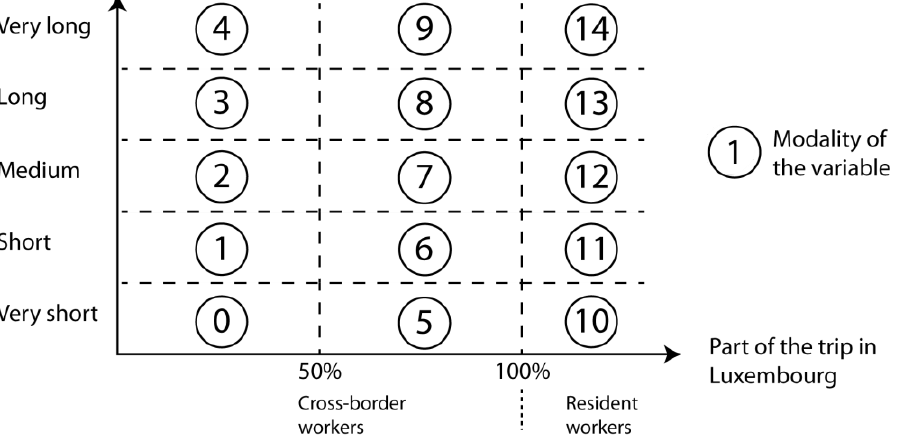
Figure 3. Synthetic border variable: cross-border trip distance and percentage of distance travalled within